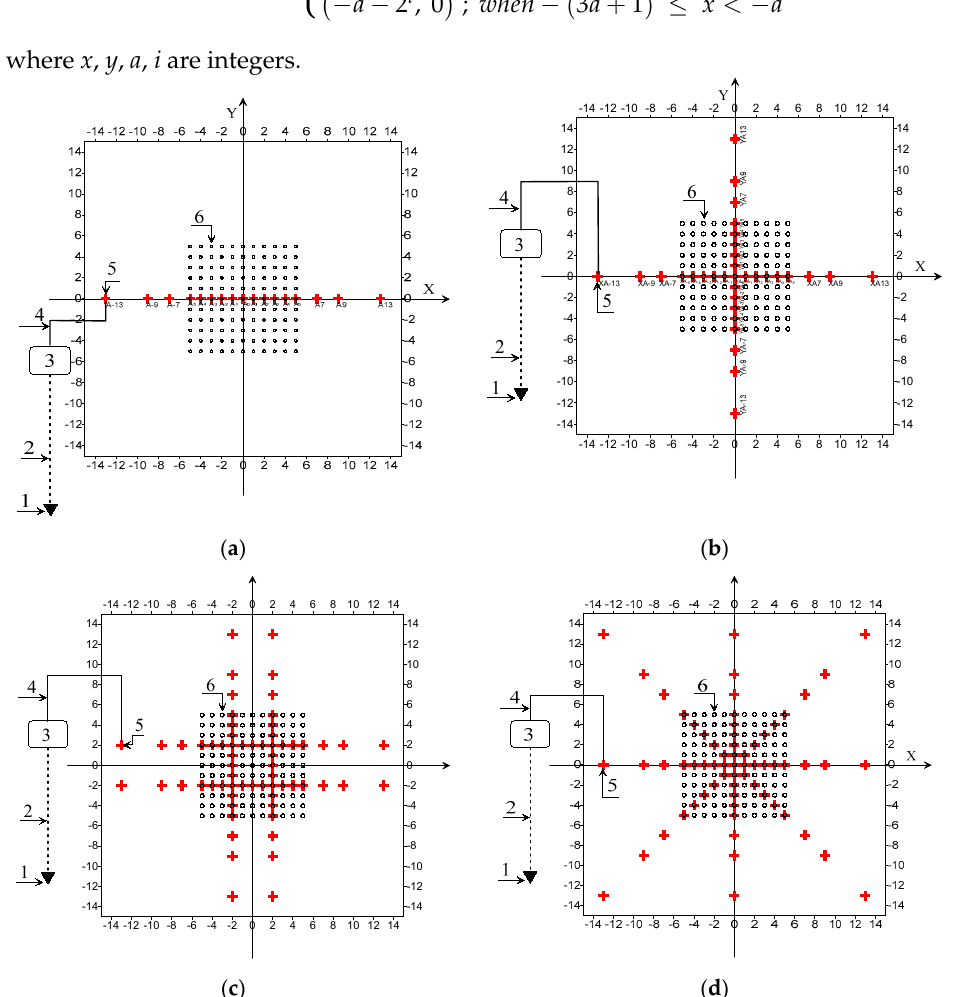
Figure 1. The observation system of pseudo − 3D resistivity surveying, ( a ) inline shape, ( b ) crisscross shape, ( c ) “ # ” shape, and ( d ) “ * ” shape.